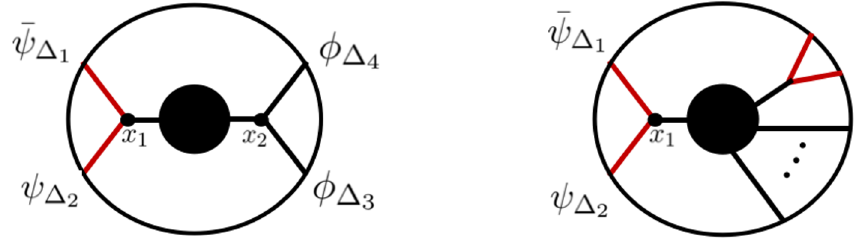
Figure 2 . Left: like figure 1-right, only here the x 2 vertex has scalar propagators attached to it. Right: a completely general diagram in AdS, which has a vertex x 1 to which are attached two fermionic bulk-to-boundary